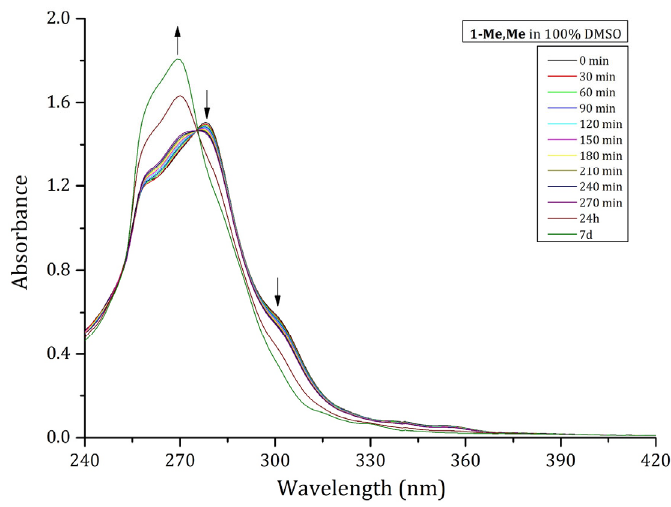
Int. J. Mol. Sci. 2023 , 24 , x FOR PEER REVIEW Figure 5. Time ‐ course UV–vis spectra of 50 μ M of 1 ‐ Me,Me in DMSO. Figure 5. Time-course UV–vis spectra of 50 µ M of 1-Me,Me in DMSO.